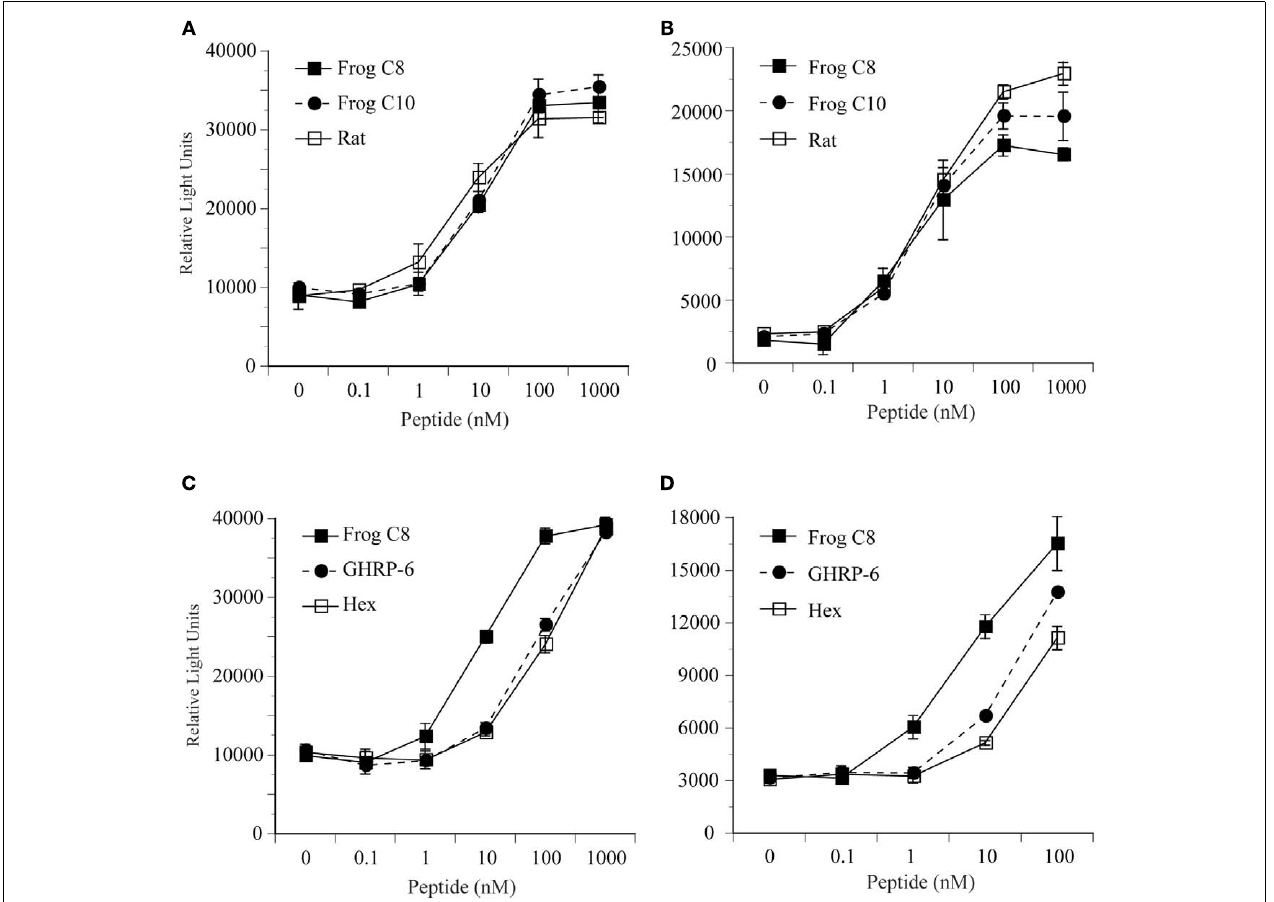
treated with bullfrog ghrelin 28-C8, 28-C10, and rat ghrelin (A,B) , and bullfrog ghrelin 28-C8, GHRP-6, and hexarelin (C,D) at concentrations of 0, 0.1, 1, 10, 100, or 1000nM.Values represent the means ± SEM of triplicate experiments by one